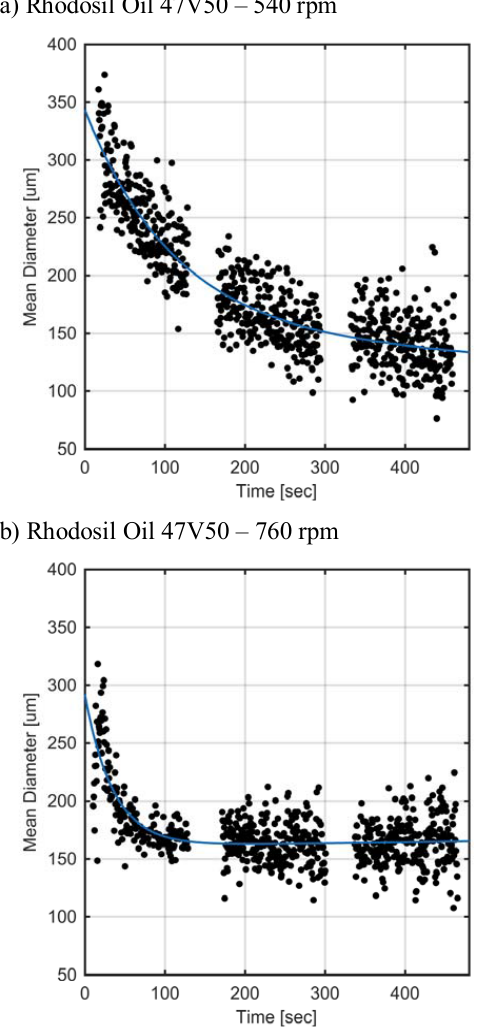
Fig. 2. Mean Particle Diameter time dependence of Rhodosil Oil 47V50 for a) 540rpm, and b) 760 rpm stirrer